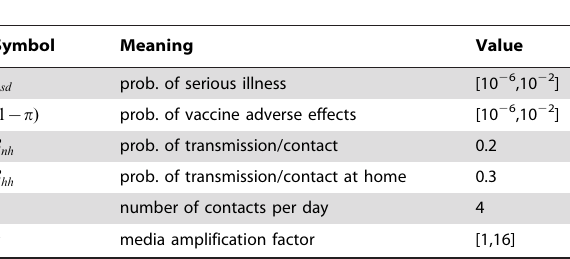
Table 1. Parameter values used for the